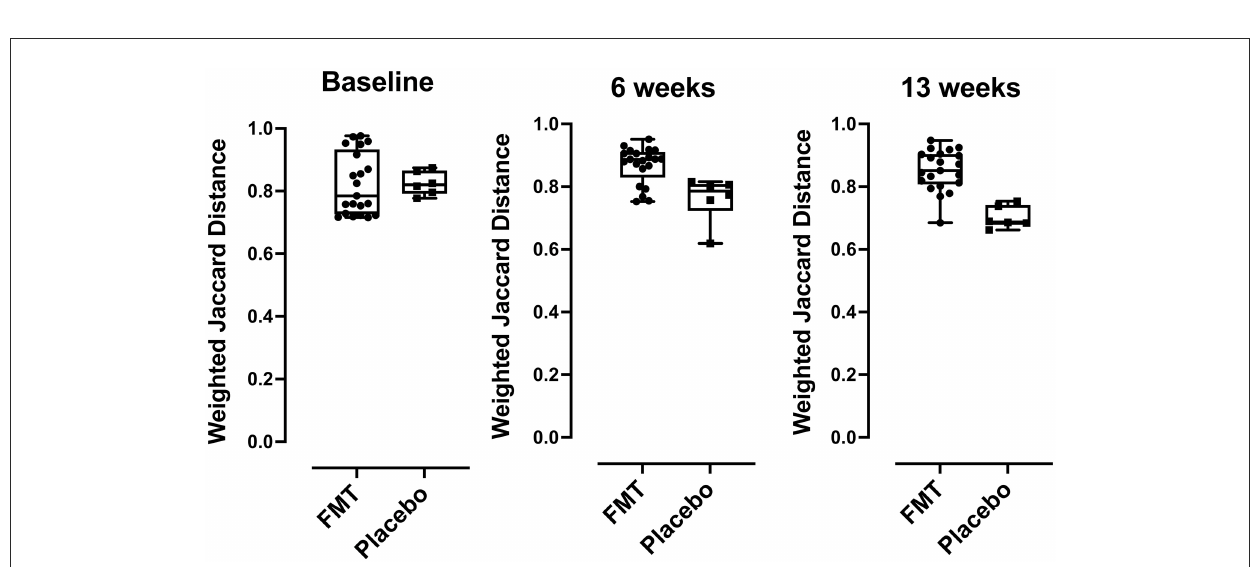
FIGURE3 Beta diversity (taxa) differences comparing FMT- and placebo-treated subjects, comparisons of Jaccard distances between FMT and placebo recipients were compared using box plots. Over time, subjects in the placebo group had bacterial community compositions more similar to each other than those in the FMT group at baseline ( p < 0.629), at 6 weeks p < 0.008, and at 13 weeks ( p < 0.0008) post FMT. P -values were determined using the Mann-Whitney